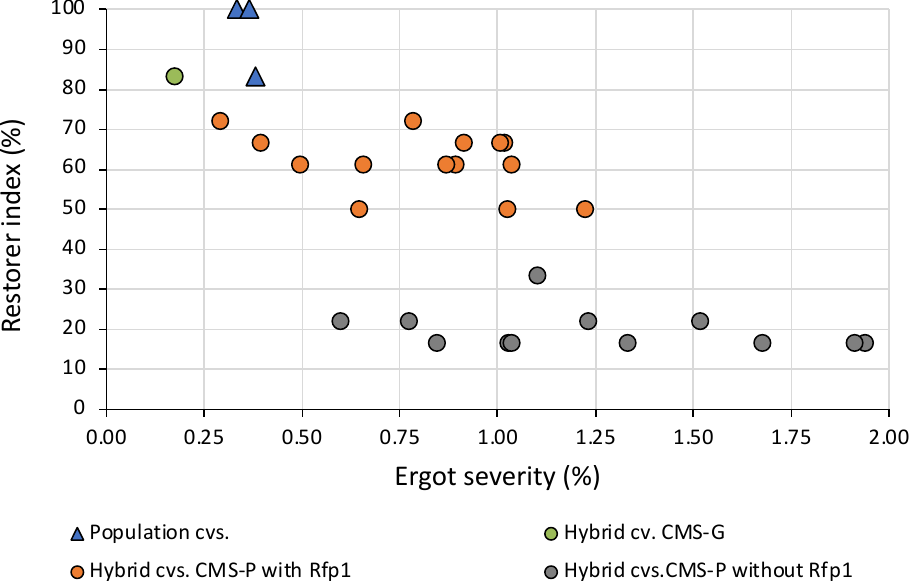
Figure 8. Ergot severity and restorer index of the entries of the Official VCU trials from Germany in 2021 after artificial ergot infection across four locations (cv./cvs = cultivar/s, G=G cytoplasm, P=P cytoplasm).